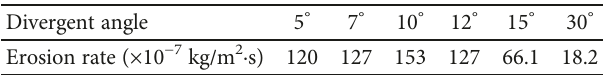
Table 5: Erosion rate of rock at di ff erent divergent angles.